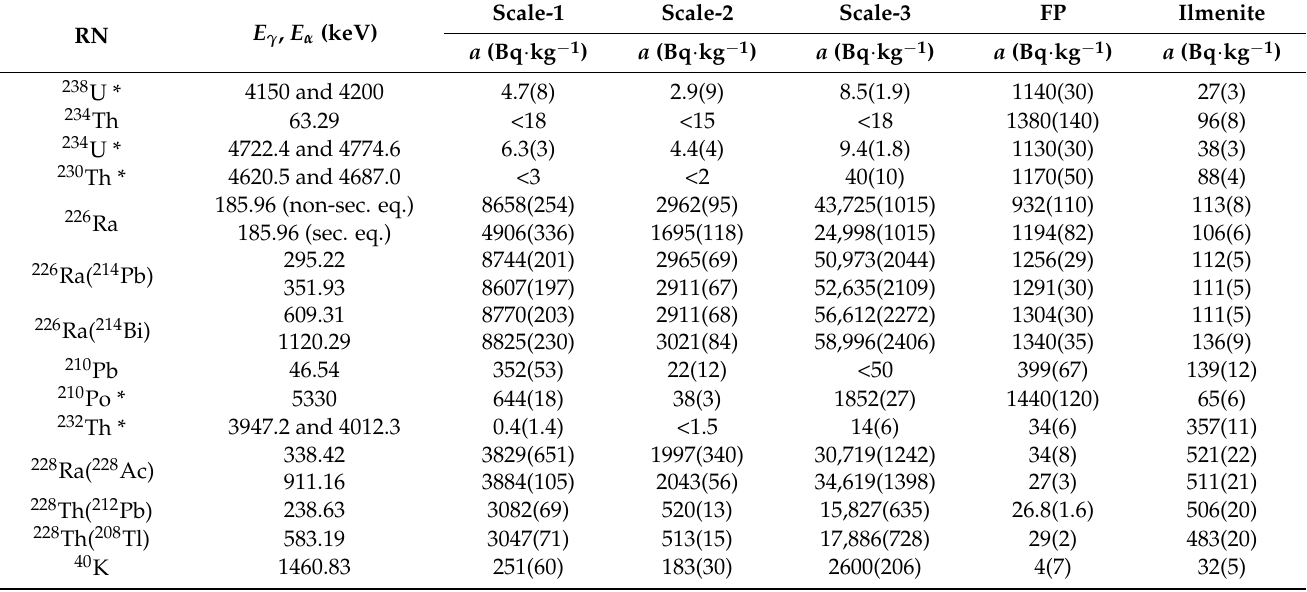
Table 3. Activity concentrations obtained for gamma-ray and pure-alpha emitters contained in several scale samples (from Scale-1 to Scale-3), a final product (FP), and an ilmenite (Ilmenite), where E γ and E α are the emissions selected to determine the gamma-ray and pure-alpha emitters, respectively. Furthermore, in the case of the 226 Ra (186 keV), two cases were taken into account: considering and without considering secular equilibrium between 238 U and 226 Ra (sec. eq. and non-sec. eq., respectively). Uncertainties are given at 1 sigma level. (*) Radionuclides determined using alpha-particle